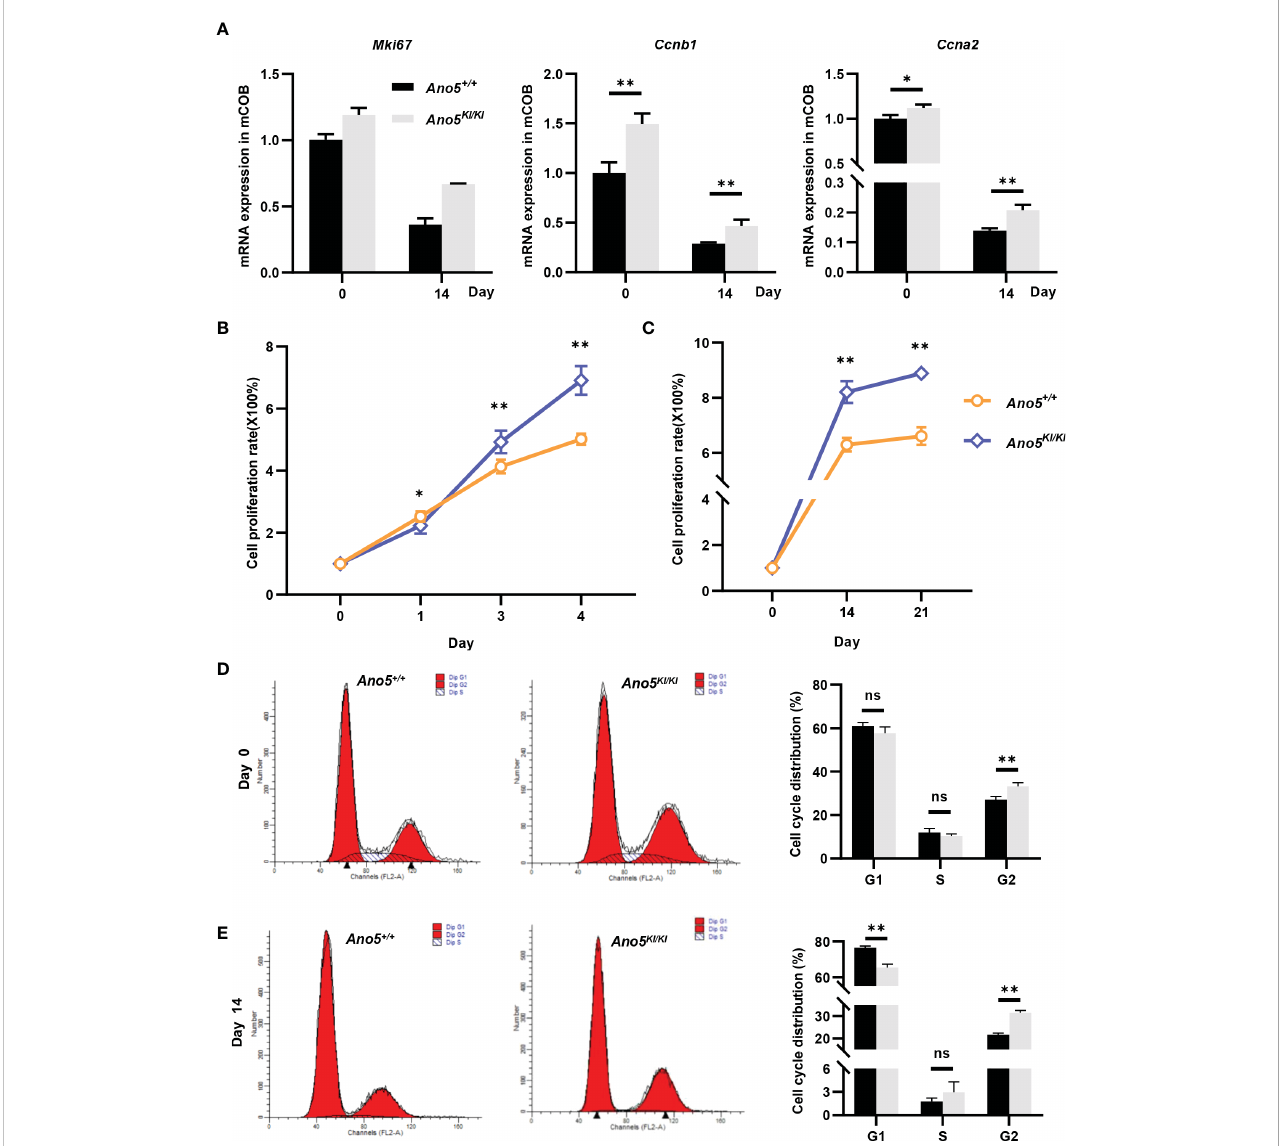
FIGURE 6 Cellular prolieration and cell cycle analysis in Ano5 +/+ and Ano5 KI/KI mCOBs. (A) Relative expression of Mki67 , Ccnb1 , and Ccna2 in Ano5 KI/KI compared with Ano5 +/+ mCOBs at days 0 and 14 after osteogenic induction; (B, C) Cellular proliferation was evaluated using CCK-8 assays at days 1, 3, and 4 without os Please expand the term "ns" in Figures 6, 7 if applicable Please expand the term "ns" in Figures 6, 7 if applicableteoblast differentiation (B) and at days 14 and 21 with osteogenic induction (C) ; (D, E) Cell cycle distributions were assessed with fl ow cytometry at days 0 (D) and 14 after osteogenic differentiation (E) . Data were analyzed using Student ’ s t- tests or one-way ANOVA tests with Dunnett ’ s multiple comparison tests. ns, no signi fi cance; * p < 0.05; ** p <